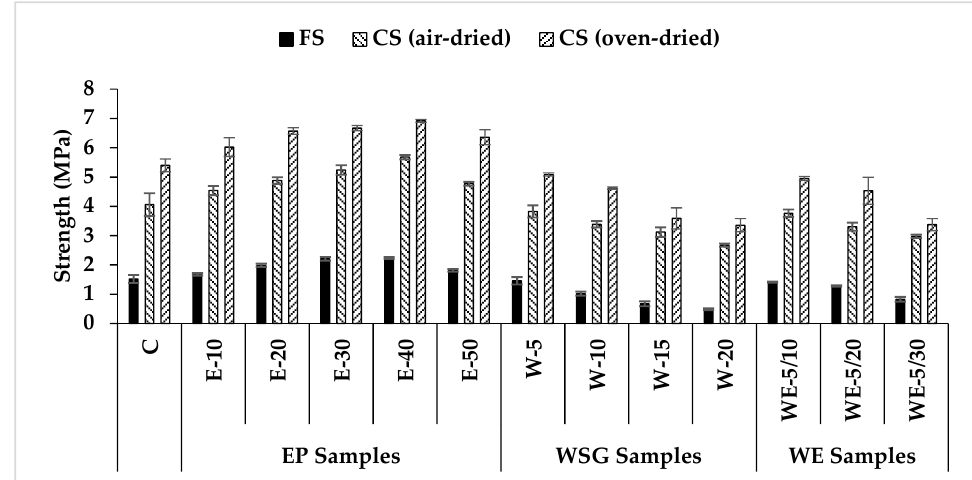
Figure 11. Test results of flexural strength (FS) and compressive strength (CS).